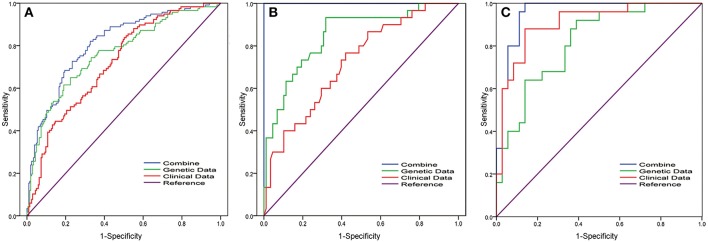
Receiver operating characteristic (ROC) curve analysis of the 12-gene signature in MIBC patients for predicting 5-years overall survival. To compare the prognostic value of the 12-gene signature, we analyzed the ROC curves of the 12-gene signature of 5-years OS in different datasets. ROC plots for the 12-gene signature predicting 5-years OS in the (A) TCGA cohort and (B) FUSCC cohort and (C) GSE13507 dataset. Clinical parameters include gender, age, T stage, grade, and N stage. Combining model was obtained by multivariate regression analysis for the combination of clinical parameter and 12-gene signature.